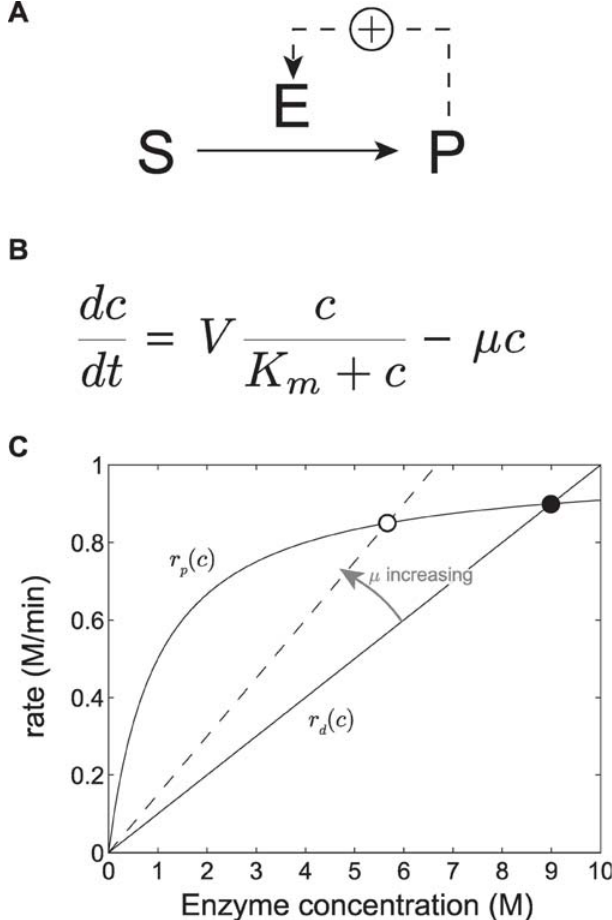
Figure 1. Example of a Dynamical System (A) Reaction schematic of an enzyme, E, catalyzing the conversion of substrate, S, to product, P. The final product acts as a catabolite to promote the expression of enzyme. (B) ODE describing the change in time of enzyme concentration, c . The first term is the production term, r ( c ), and the second term is p degradation, r ( c ). d (C) Graphical representation of r ( c ) and r ( c ). At steady state, these two p d processes will balance, and the concentration of enzyme will become constant in time, with a value corresponding to the intersection of these two curves. Increasing the degradation constant µ (depicted by shift from solid line to dashed line) changes the steady state value of c (from closed circle to open circle). The sensitivity of this steady state value of c to such changes in parameters can be quantified by the sensitivity